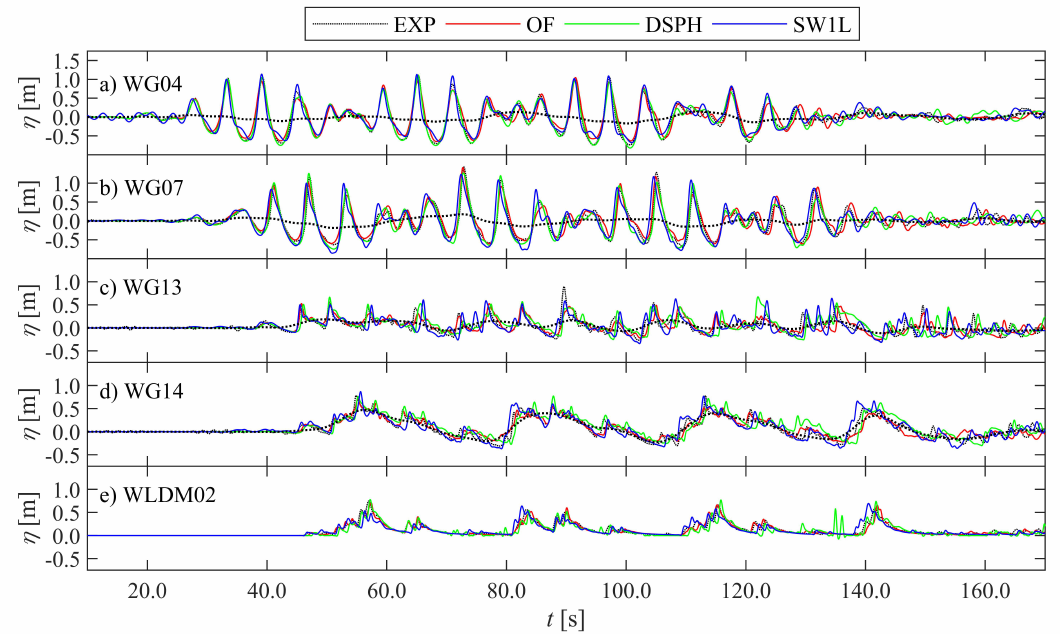
Figure 4. Comparison of the η time series at selected sensor locations ( a – e ). The zero-reference is the SWL for panels ( a – d ) and the promenade bottom for panel ( e ). Note: η LW is shown as well, but only for EXP (bold dotted lines in panels ( a – d )). Adapted from the work in [3], with permission from the authors,